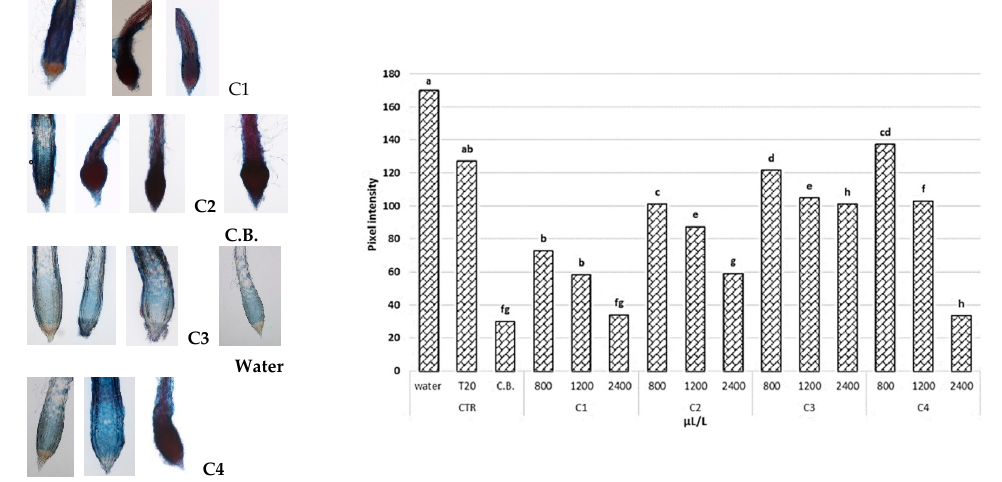
Figure 4. E ff ect of di ff erent chemotype EO concentrations on the intensity of loss of membrane integrity in roots of L. perenne stained with Trypan blue ( left ) and relative pixel intensity (lower intensity indicates a higher staining blue intensity and a higher loss of membrane integrity) ( right ). C1 : α -pinene, C2 : camphor, C3 : α -pinene / 1,8-cineole, C4 : α -pinene / camphor / 1,8-cineole. CTR: water, T20: Tween 20 and C.B: Commercial bio-herbicide. Means with the same letter are not significantly di ff erent at p ≤ 0.05 significant level (Tukey’s